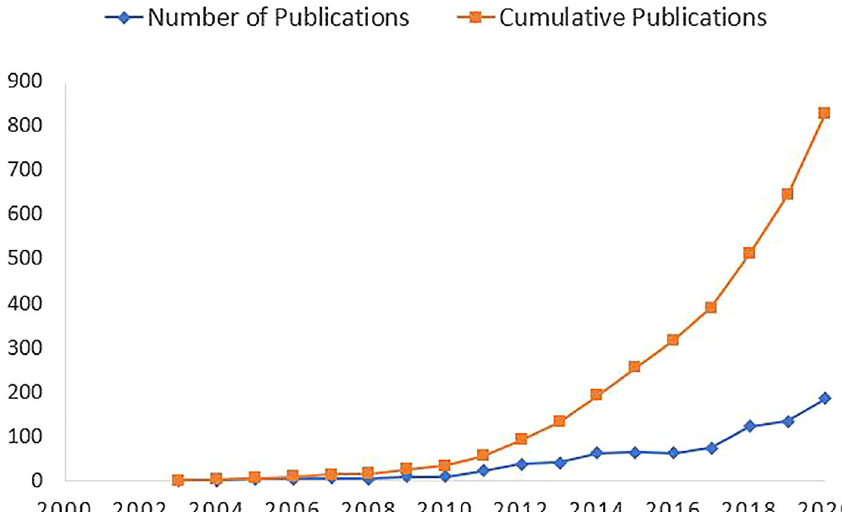
Figure 2. Trends of scholarly publications on syndemic.